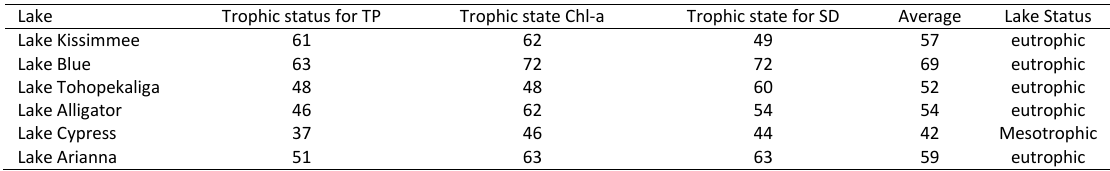
Table 2: Trophic status for lakes of Osceola and Polk counties